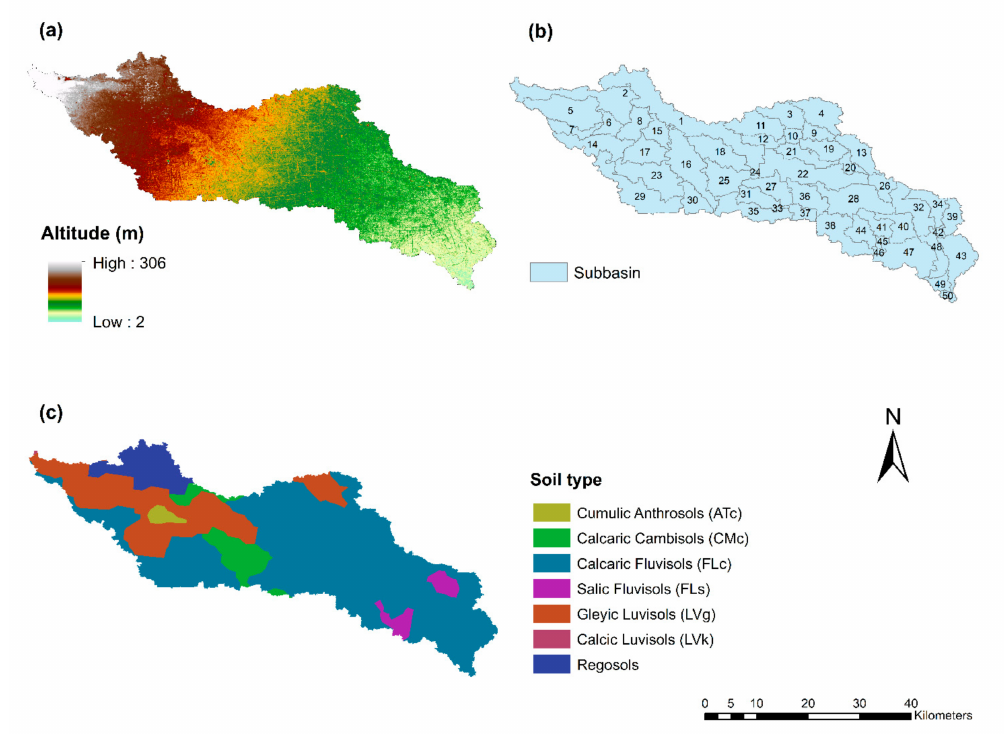
Figure 2. Map showing the digital elevation model (DEM) ( a ), sub-basins ( b ), and soil types ( c ) of the Liangshuihe